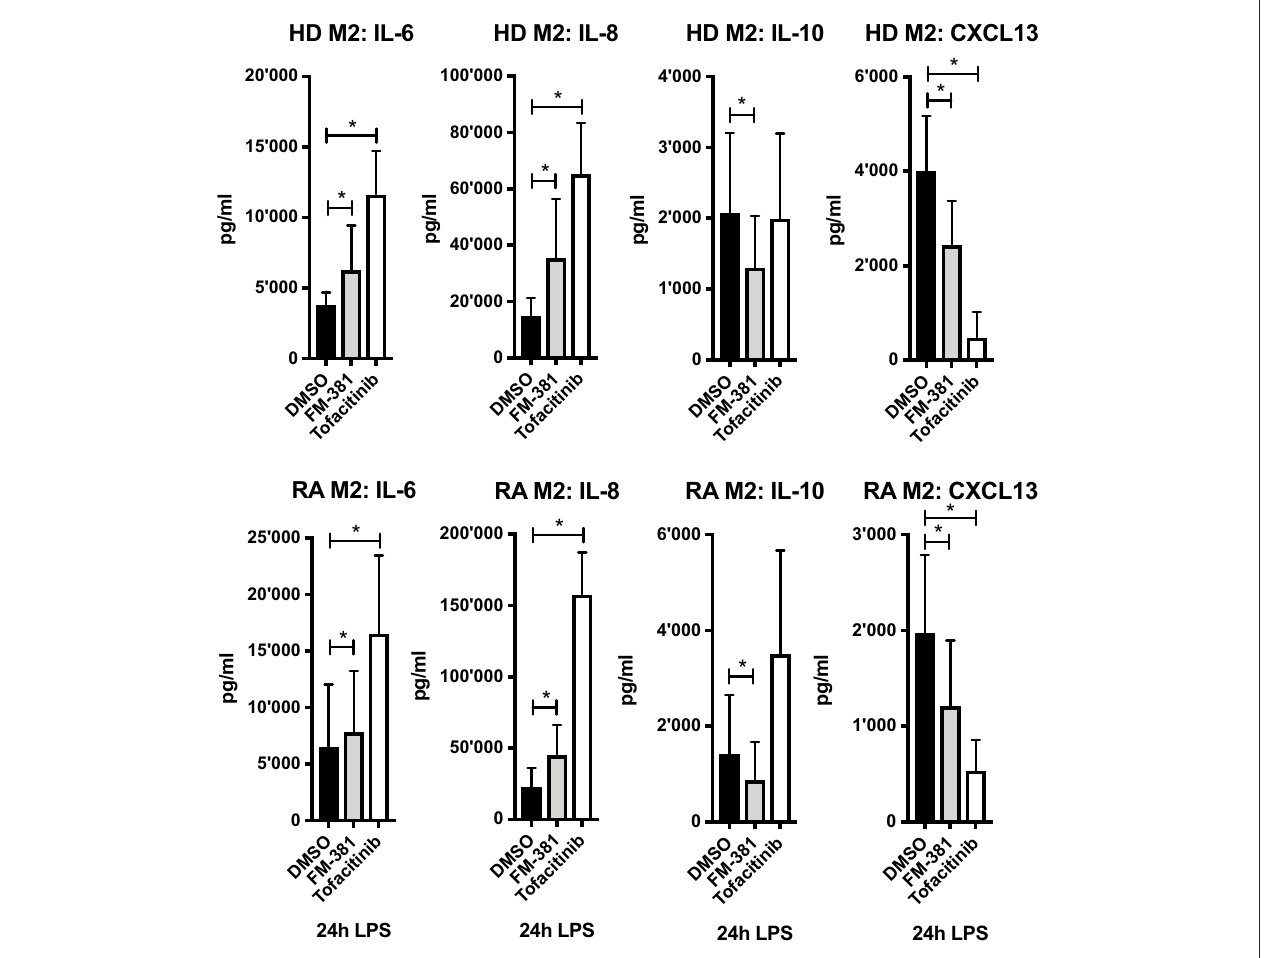
FIGURE 7 | JAK3 activity was inhibited in generated M2-macrophages from blood of HD or RA patients using two selective JAK inhibitors FM-381 and Tofacitinib. Cells were treated 1h before LPS stimulation with 1 µ M JAK inhibitor or DMSO control. Cytokine and chemokine secretion were measured by ELISA after stimulation with LPS for 24h. Values are expressed as mean ± S.D. N = 3–8, * p <